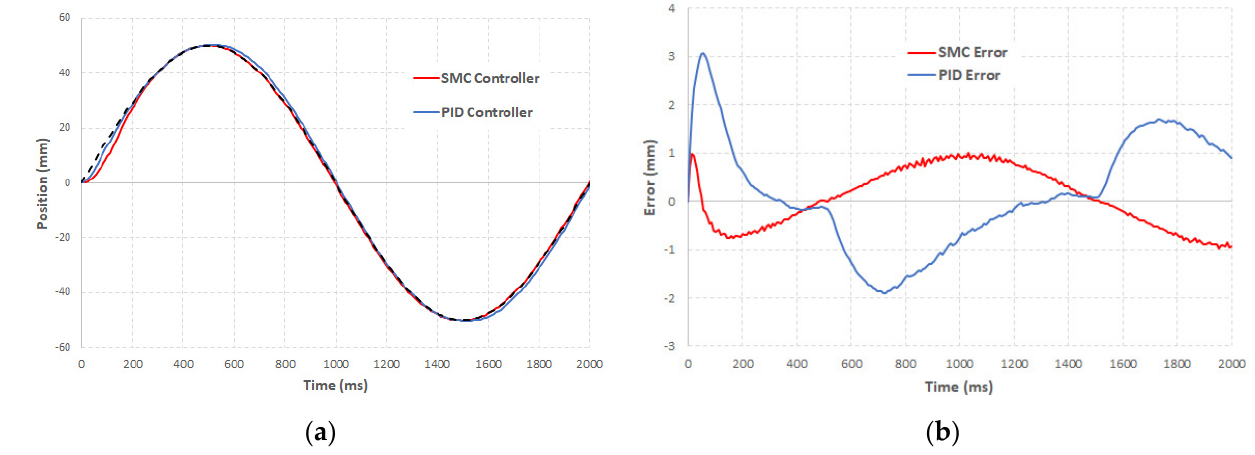
Figure 5. Control performances of the SMC and PID controllers in 0.5 Hz sinusoidal tracking: ( a ) comparison of desired (black dashed line) and measured trajectories; ( b ) tracking errors.